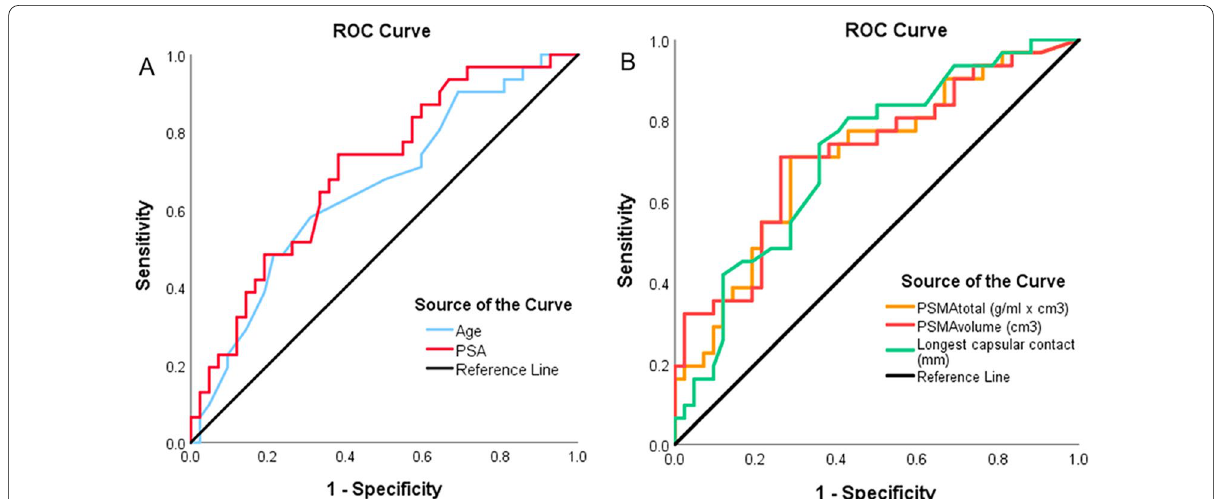
Fig. 3 a ROC curves analysis for Age and PSA values prediction of EPD. An age of 65.5 y reached an AUC of 0.654, sensitivity of 58.1%, and specificity of 69%. A PSA value of 8.75 ng/ml reached an AUC of 0.7, sensitivity of 74.2%, and specificity of 61.9% b ROC curve analysis for PSMA tot , PSMA vol and LCC and PSA values prediction of EPD. A PSMA tot of 24.6 g/ml reached an AUC of 0.709, sensitivity of 71%, and specificity of 71.4%. A PSMA vol of 4.41cm 3 reached an AUC of 0.718, sensitivity of 71%, and specificity of 73.8%. An LCC of 16.5 mm reached an AUC of 0.712, sensitivity of 74.2%, and specificity of 64.3%